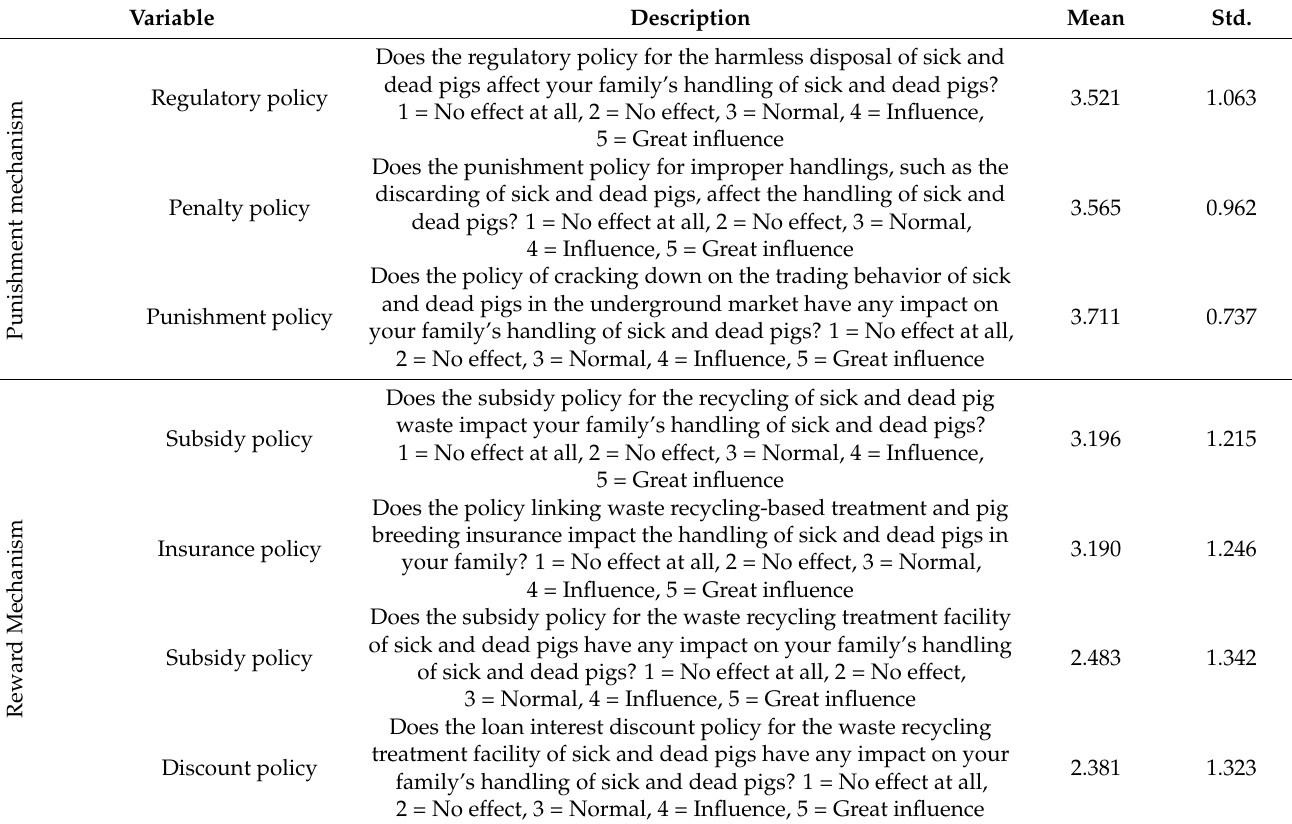
Table 2. Descriptive statistics of the